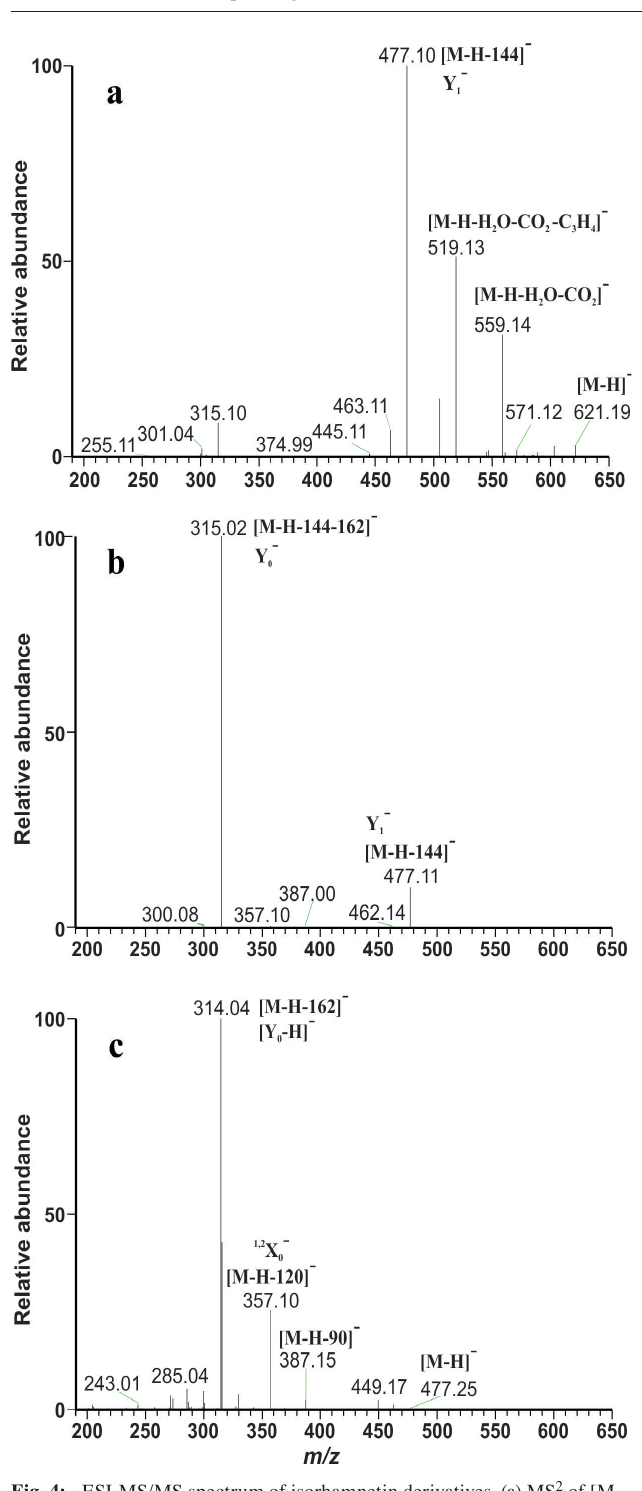
Fig. 4: ESI-MS/MS spectrum of isorhamnetin derivatives. (a) MS 2 of [M − H] − at m/z 621 and (b) MS 3 (621 → 477) of compound 2C . (c) MS 2 of [M − H] − at m/z 477 of compound 11S